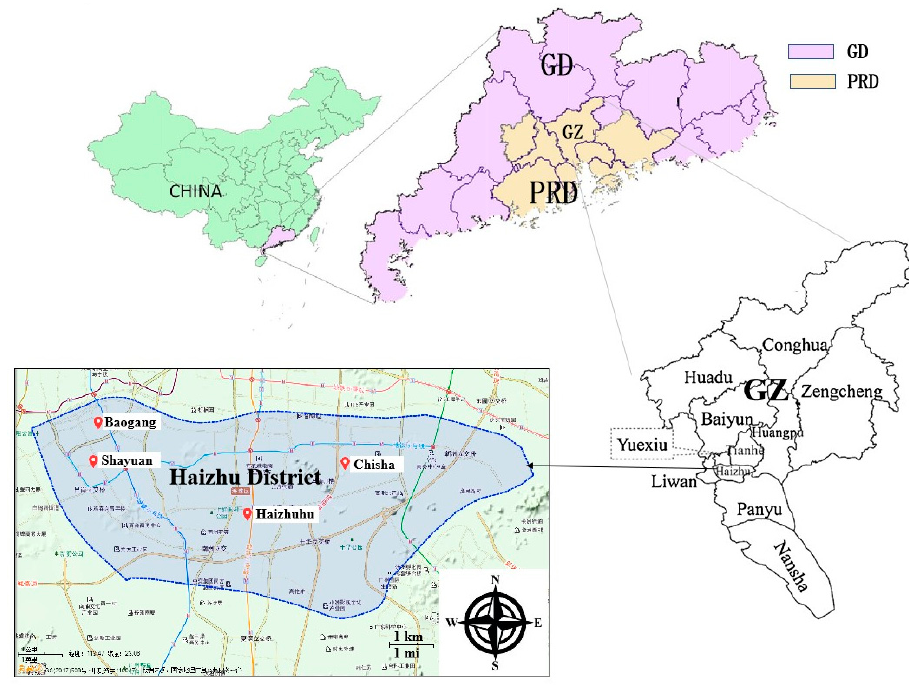
Figure 1. The Haizhu region and its location (GD: Guangdong province; PRD: Pearl River Delta; GZ: Guangzhou) [14,41,42].